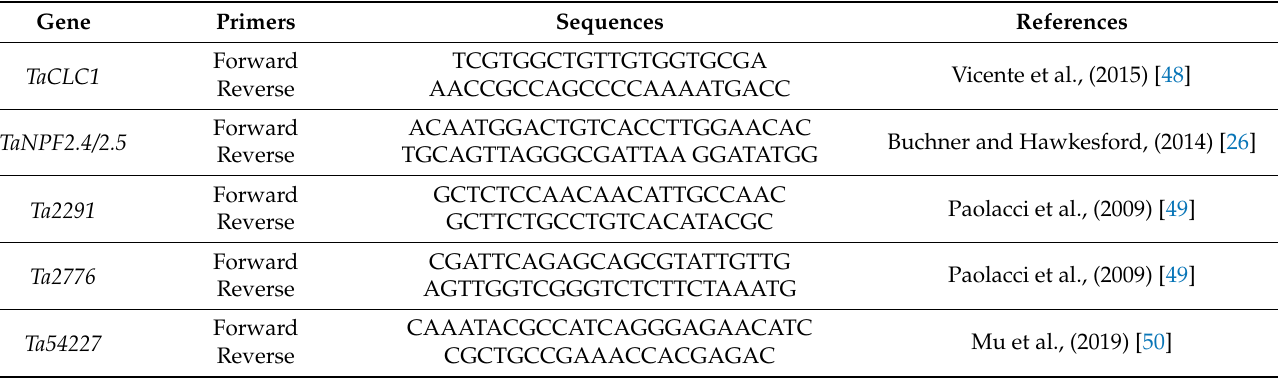
Table 2. The gene-specific primers used for